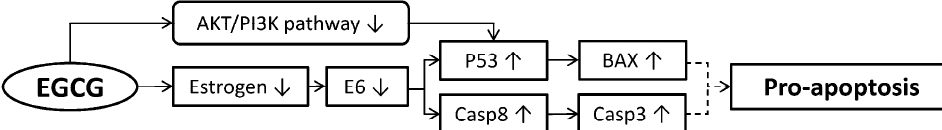
Figure 3. Molecular mechanisms of EGCG promoting apoptosis of cervical cancer cells. EGCG down-regulated E6 through estrogen, then the expressions of P53 and casp8 were up-regulated. EGCG also could increase P53 expression by AKT/PI3K pathways. BAX and casp3 would promote their expressions with up-regulation of P53 and casp8 respectively. The up-regulation of BAX and casp3 could promote apoptosis of cervical cancer cells in the end (broken lines mean indirect approaches).